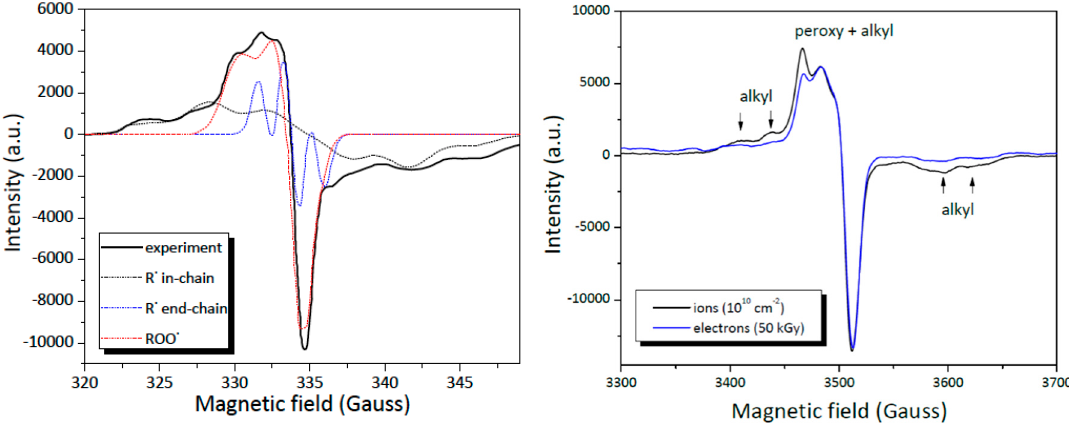
Figure 9. EPR spectra of 9 µm β -PVDF films irradiated by (left) e-beam (1.25 MGy); (right) Swift Heavy Ions (krypton of 10MeV / amu, fluence of 10 10 cm − 2 corresponding to 76 kGy) and e-beam (50 kGy). The EPR parameters of identified radicals consistent with [199–202] are collected in Table 1.